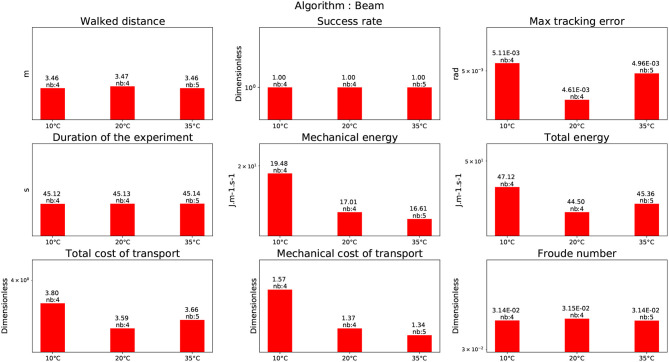
Walking on a beam.